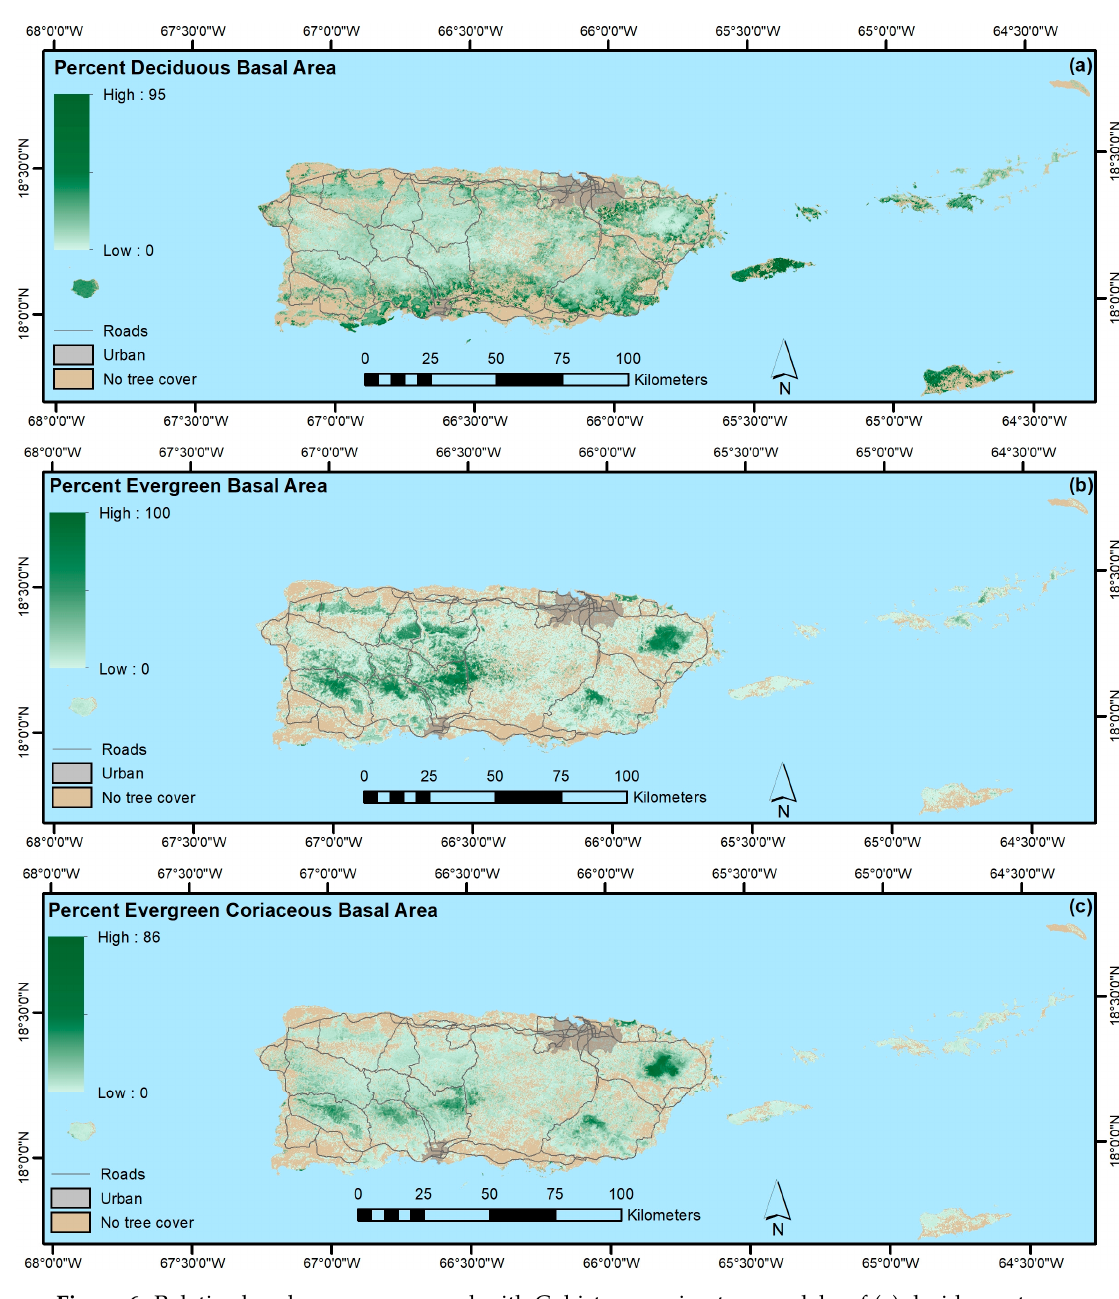
Figure 6. Relative basal areas, as mapped with Cubist regression tree models, of ( a ) deciduous tree species, ( b ) evergreen tree species, and ( c ) hard-leaved (coriaceous) evergreen tree species.